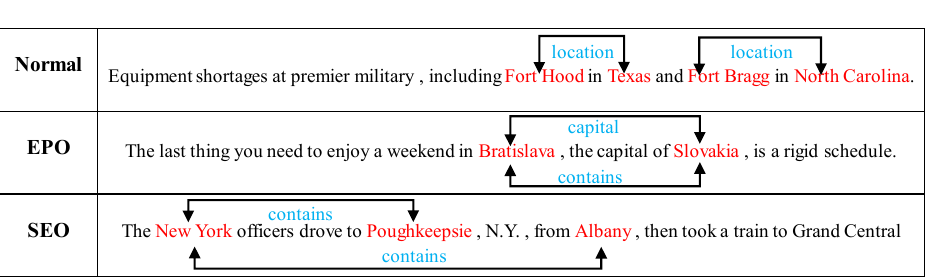
Figure 1. Examples of normal, EPO, and SEO overlapping problems.